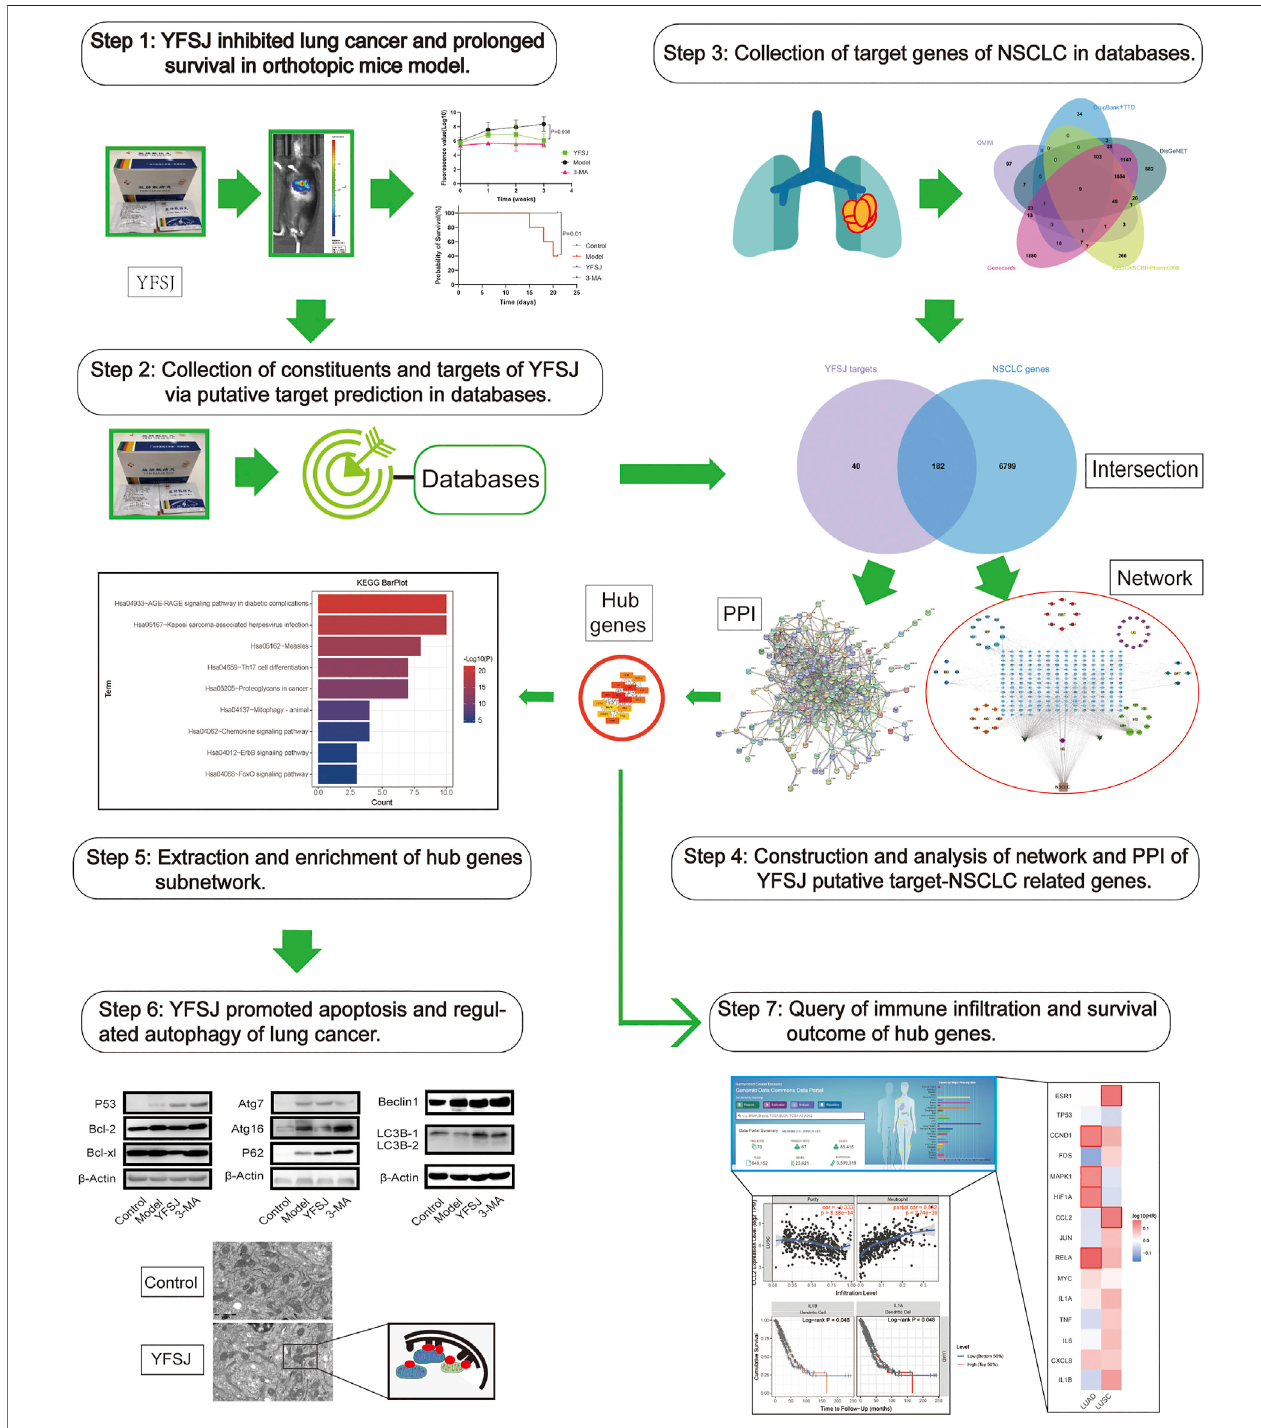
FIGURE 1 | The graphical abstract of the systematic strategies for the determination of the pharmacological mechanisms of YFSJ on NSCLC.